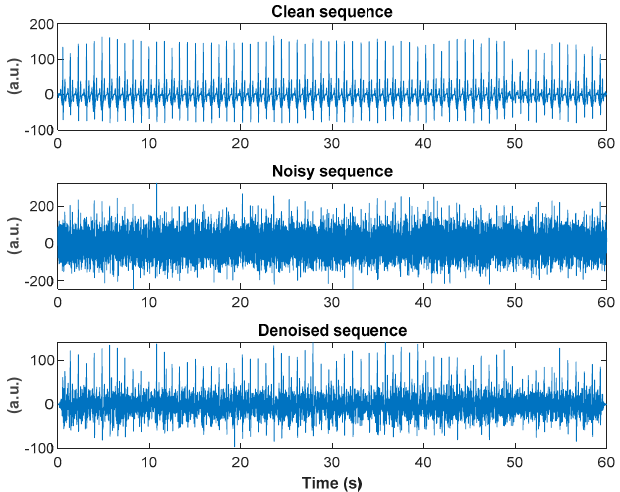
Figure 5. Illustrative example of one typical 60-s sequence from the MIT-BIH arrhythmia database and its corresponding noisy (corrupted with white noise with SNR = − 5 dB) and denoised sequences.